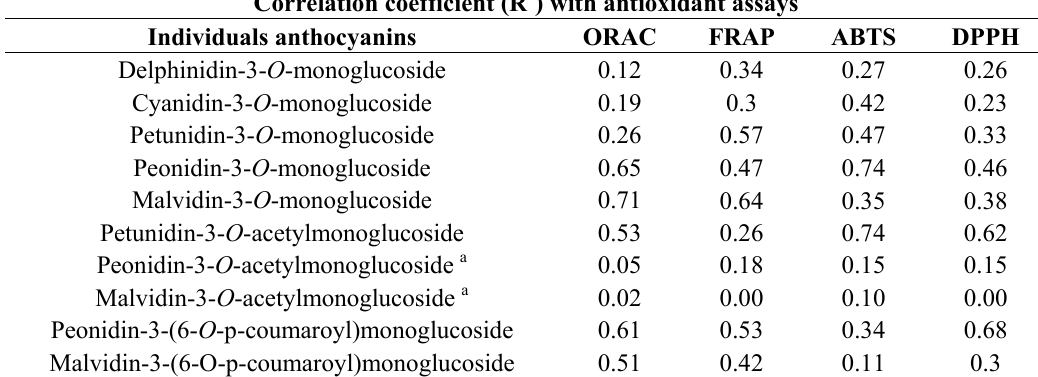
Table 7. Correlation coefficients between individual anthocyanins content and their radical scavenging capacity assays (ORAC, FRAP, ABTS and